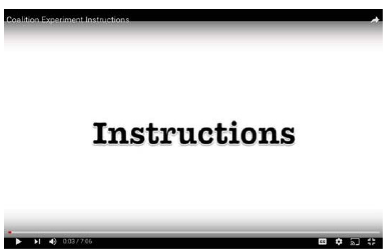
Figure A1. Screenshot of the instructions video.